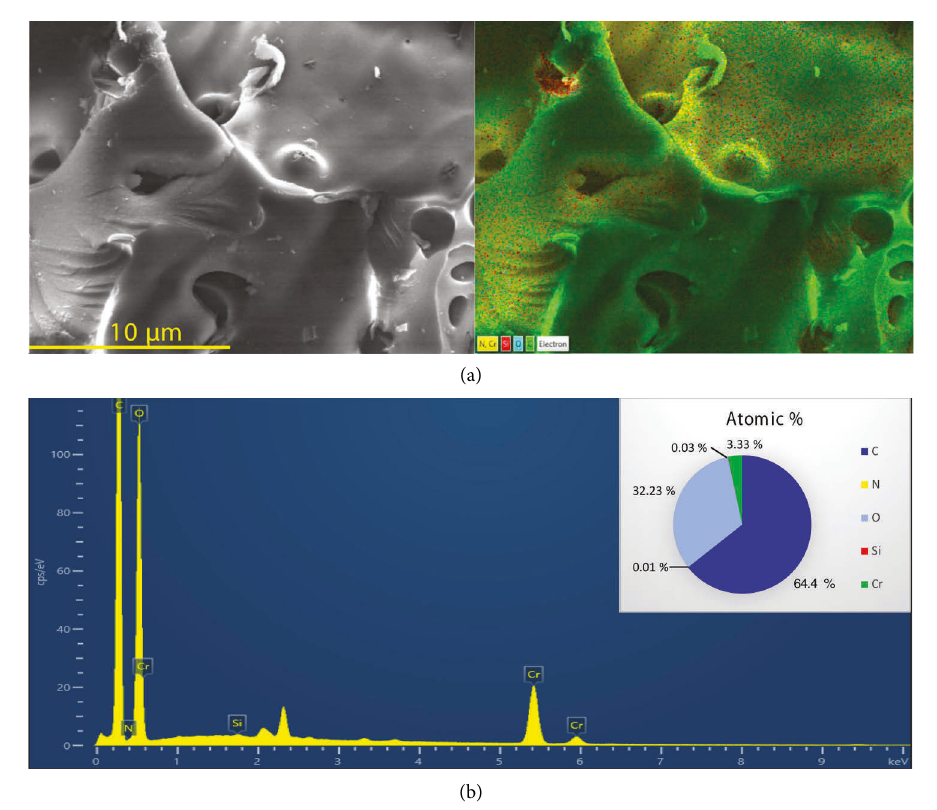
Figure 5: (a) EDX electron and layered images and (b) EDS atomic percentage of the Cr(VI)-loaded